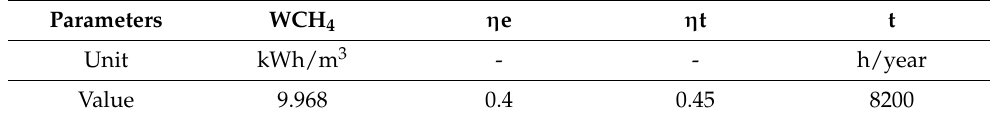
Table 3. Factors used for energy calculation [62].